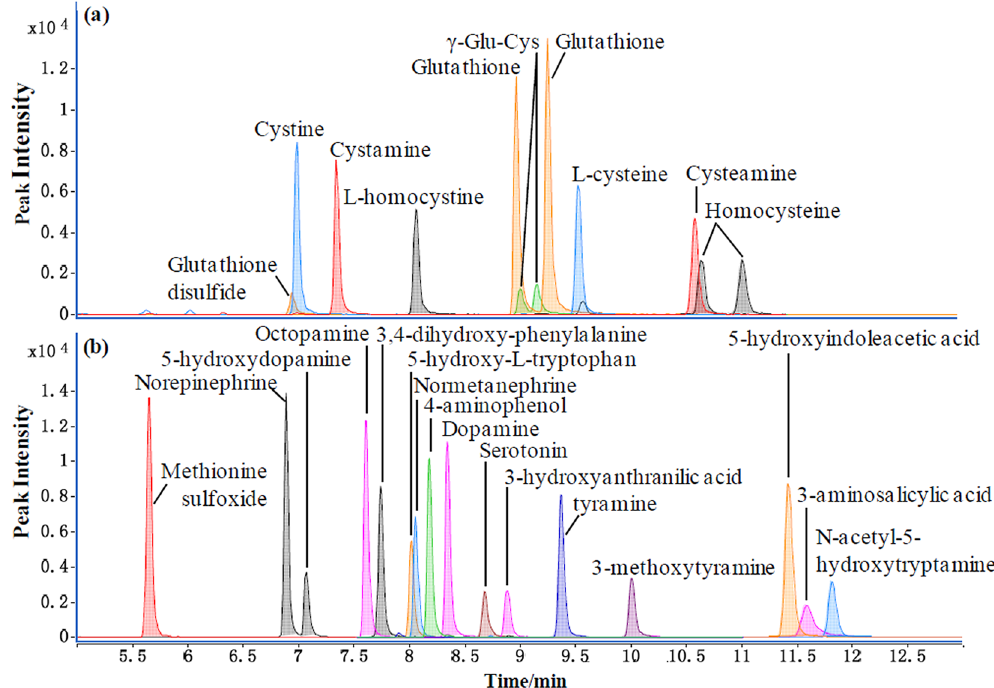
Figure 4. UHPLC-MS/MS chromatograms for the 5-AIQC-tagged oxidation-prone amino analytes including ( a ) these containing thiol and disulfide groups and ( b ) the aromatic metabolites from three aromatic amino acids (phenylalanine, tyrosine and